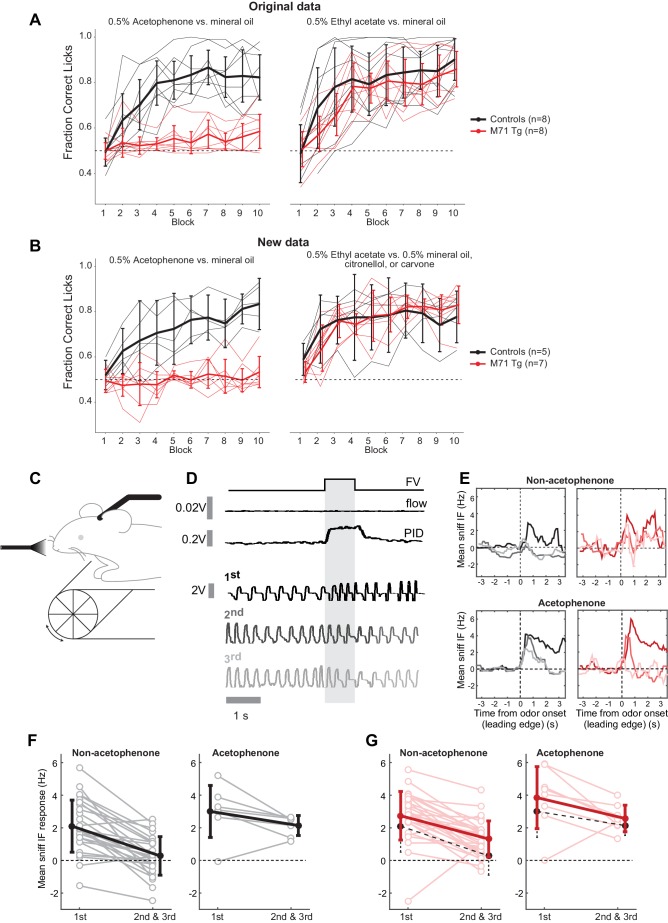
The ability of M71 transgenic mice to detect acetophenone is task-dependent.(A, B) In a go/no go operant conditioning task, M71 transgenic mice fail to discriminate acetophenone from mineral oil (left panels). In contrast, M71 transgenic mice readily discriminate other pairs of odorants (ethyl acetate vs. mineral oil, citronellol, or carvone, right panels). (A) Original results reported in Fleischmann et al. (2008). (B) Repeat experiment with an additional cohort of mice. Thin lines: learning curves for individual mice. Thick lines: averaged learning curves. Error bars: 95% CI of the mean. (C) Sniff adaptation: schematic of the experimental configuration. (D) Example sniff traces during first 3 (1st, 2nd, and 3rd) presentations of hexanone (shaded area) from a control mouse. Lighter colored traces signify later presentations. ‘FV’ trace shows opening of final valve directing odorized air to the mouse, ‘flow’ trace shows the output from the olfactometer, and ‘PID’ trace shows signal evoked by odorized air from a photo-ionization detector. (E) Example moving averages of instantaneous sniff frequency during first 3 presentations of hexanone (window = 500 ms, plotted against leading edge). Black traces: controls, red traces: M71 transgenic mice. (F, G) Mean instantaneous sniff frequency responses to first vs. the average of the 2nd and 3rd presentation of an odor for control (black, F) and M71 transgenic (red, G) mice. Pooled non-acetophenone odorants: hexanone, ethyl acetate, heptanal, and an odor mixture. Lighter colors: individual trials, thick lines: averages. Error bars: SD. Black dotted lines on the M71 plots show the means for the corresponding data from controls.